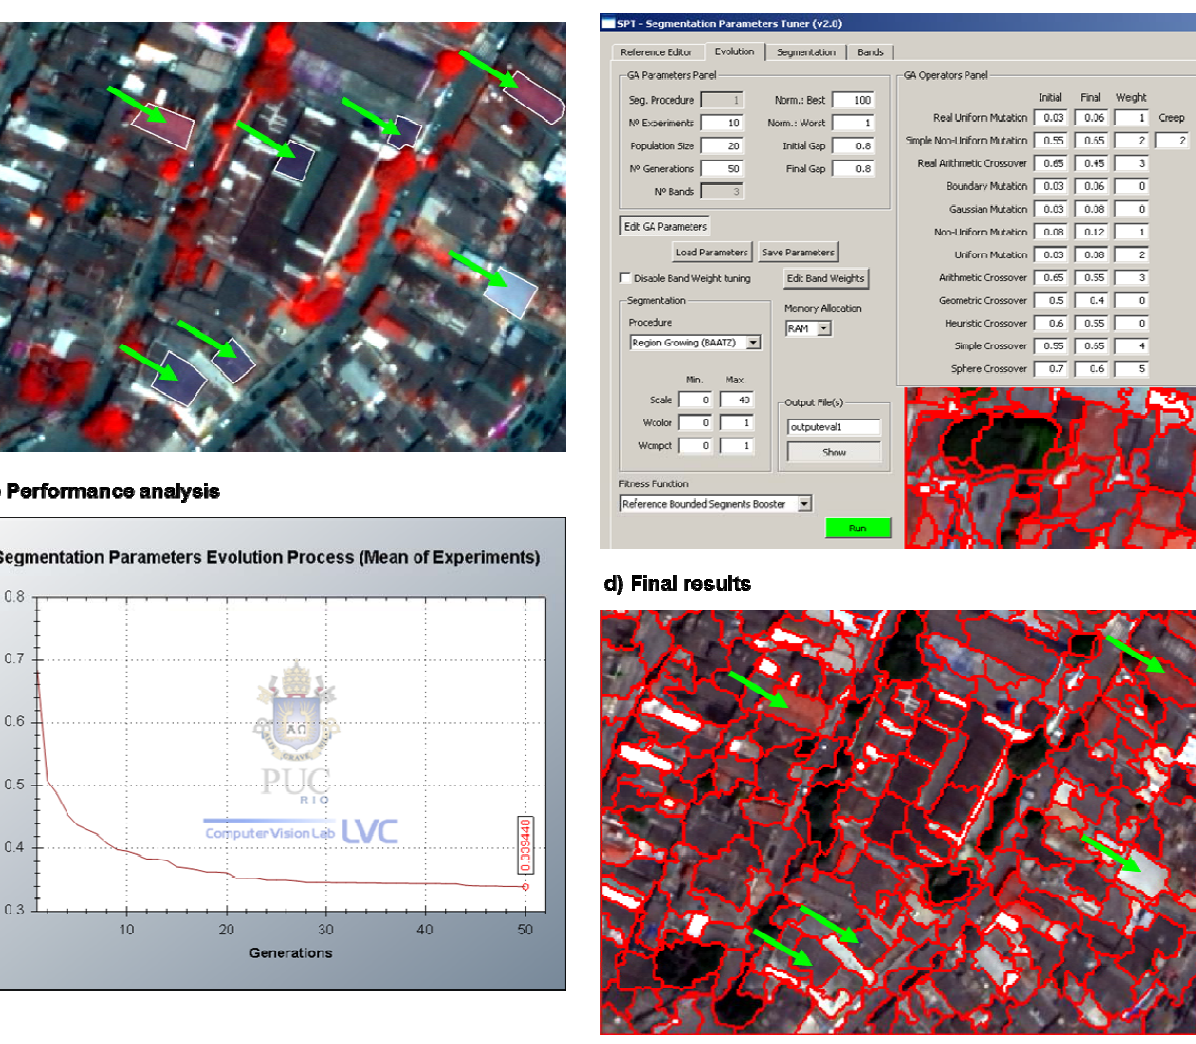
Figure 1. Sequence of procedures for the calibration of segmentation parameters using the Segmentation Parameter Tuner (SPT) system. On parts (a) and (b) , the reference segments are drawn and the SPT parameters are set. Parts (c) and (d) refer to the final results obtained at the end of the process. Genetic Algorithm (GA).